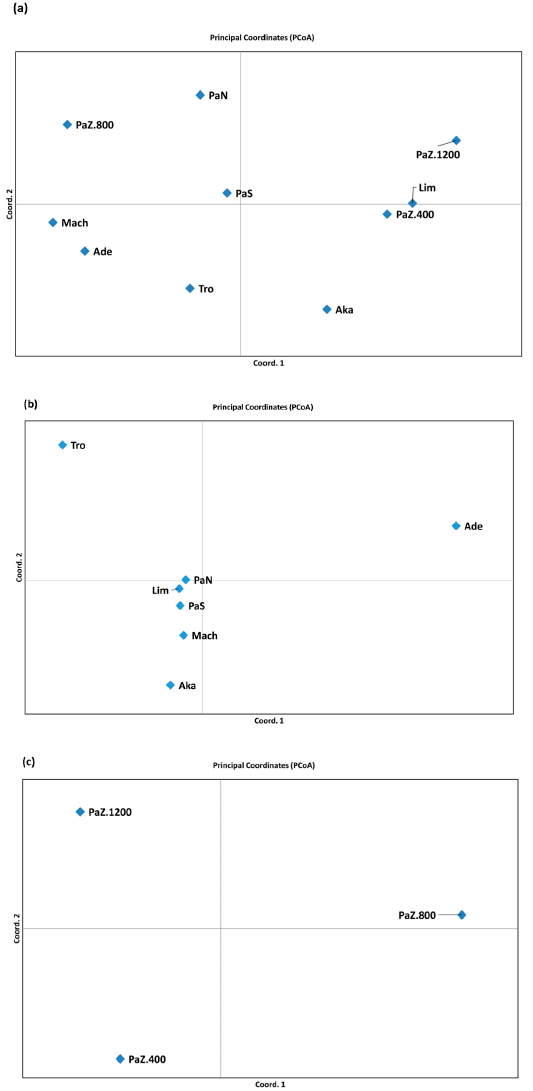
Figure 4. Two dimensional principal component analysis (PCA) plot of the genetic distance with regard to the first two principal components. ( a ) All sampled subpopulations; ( b ) wide-range subpopulation level; ( c ) altitudinal subpopulations.